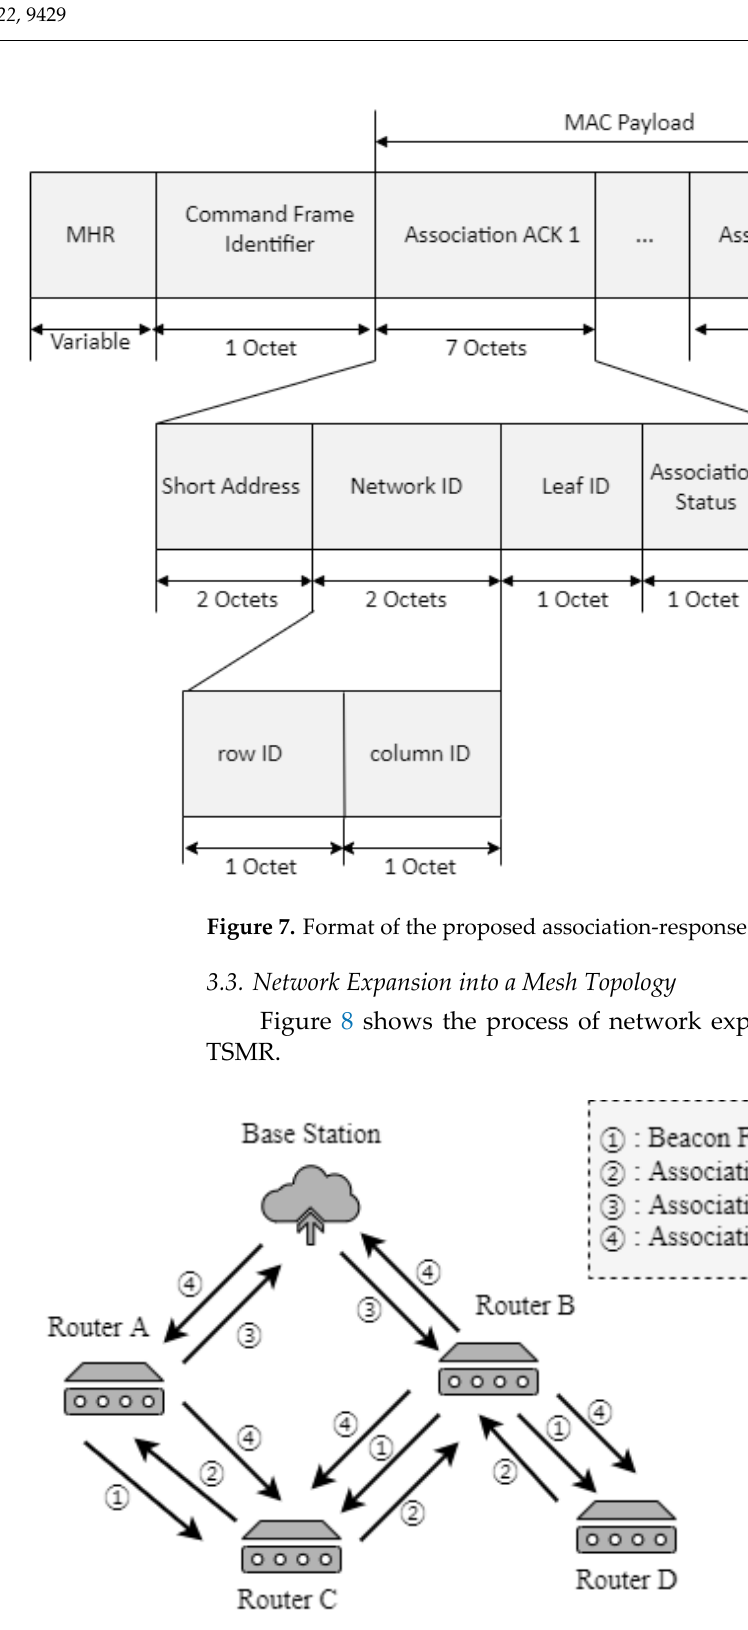
Figure 8. Process of the proposed network expansion.